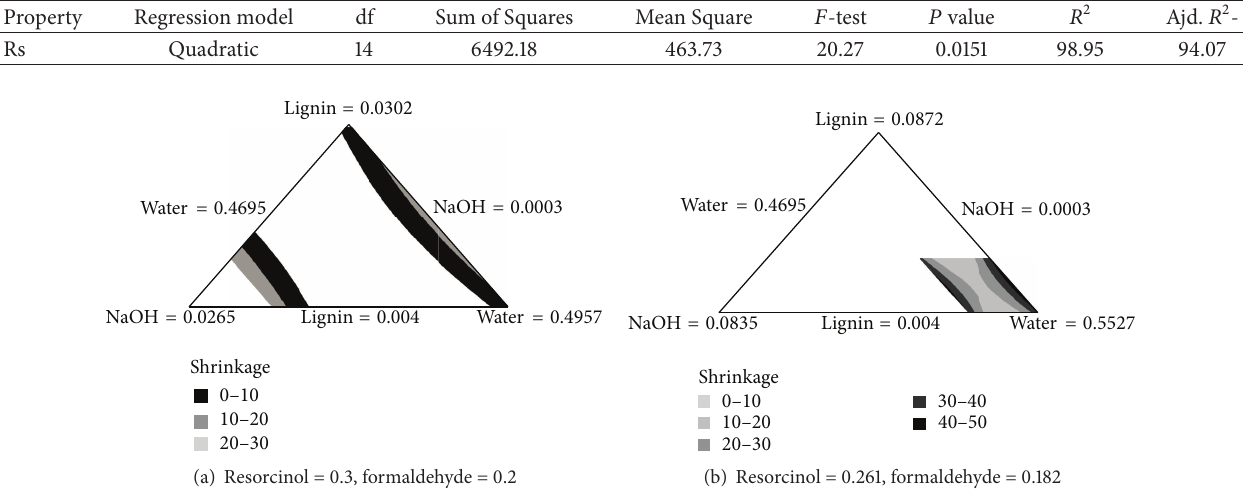
Table 3: Statistical properties of variance analysis for the significance of regression models.